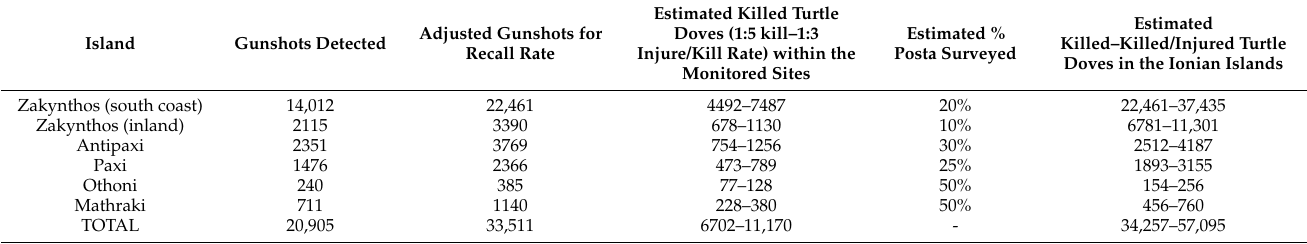
Table 2. Estimation of the number of turtle doves illegally killed during the 2021 spring migration across the Ionian Islands, based on (a) the total number of gunshots detected by the passive acoustic monitoring grid (10 sensors), (b) the adjustment of these gunshots, given the 62.4% recall rate of the gunshot detection algorithm, (c) the conversion of gunshots to killed birds using a 1:5 kill and a 1:3 killed or injured rate, and (d) extrapolation to the monitored Ionian Islands based on educated estimates on the probable proportion of the “posta” (hunting sites) monitored by the acoustic grid within each